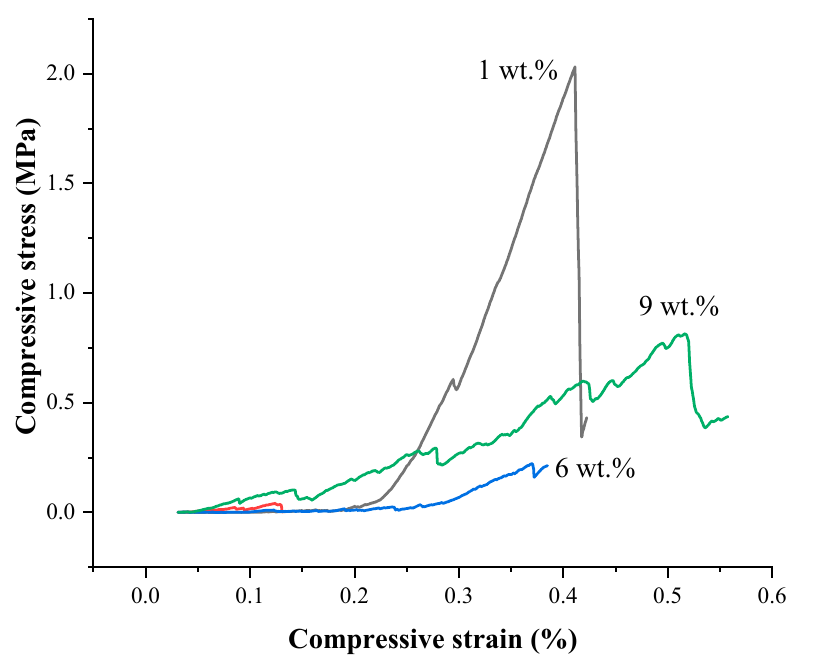
Figure 5. Stress–strain curve relative to the content of ES.